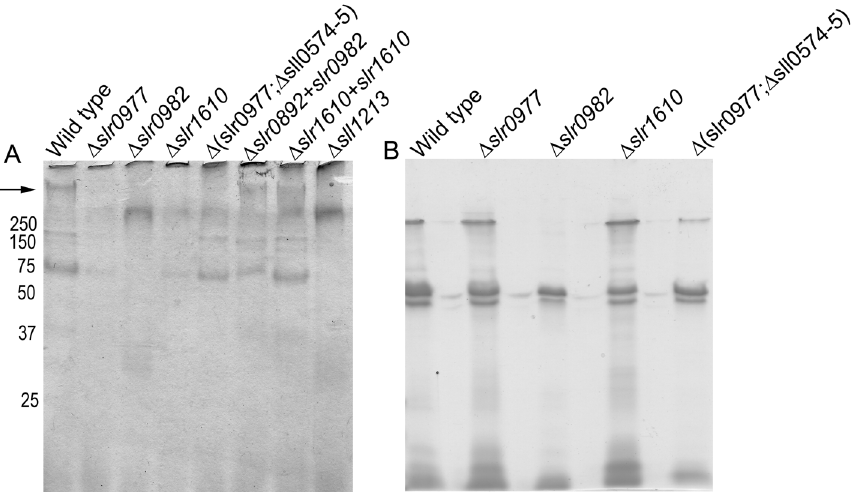
Figure 5. EPS and OMP profiles are effected by mutations in D slr0977, D slr0982, D slr1610 or in a triple mutant D (slr0977; D sll0574- 5). (A) EPS as purified from wild-type (WT) or the corresponding mutants by mechanical extraction. EPS from a D slr1213 strain is known to be deficient in EPS production and was loaded as a control. Samples were analyzed by SDS-PAGE and Alcian Blue staining. Black arrow indicates major EPS band. (B) OMP profile of wild-type or mutant Synechocystis as analyzed by SDS-PAGE and Coomassie brilliant blue staining. Molecular weights of protein standards are indicated for both analyses are indicated by numbers on the left. doi:10.1371/journal.pone.0074514.g005 PLOS ONE |